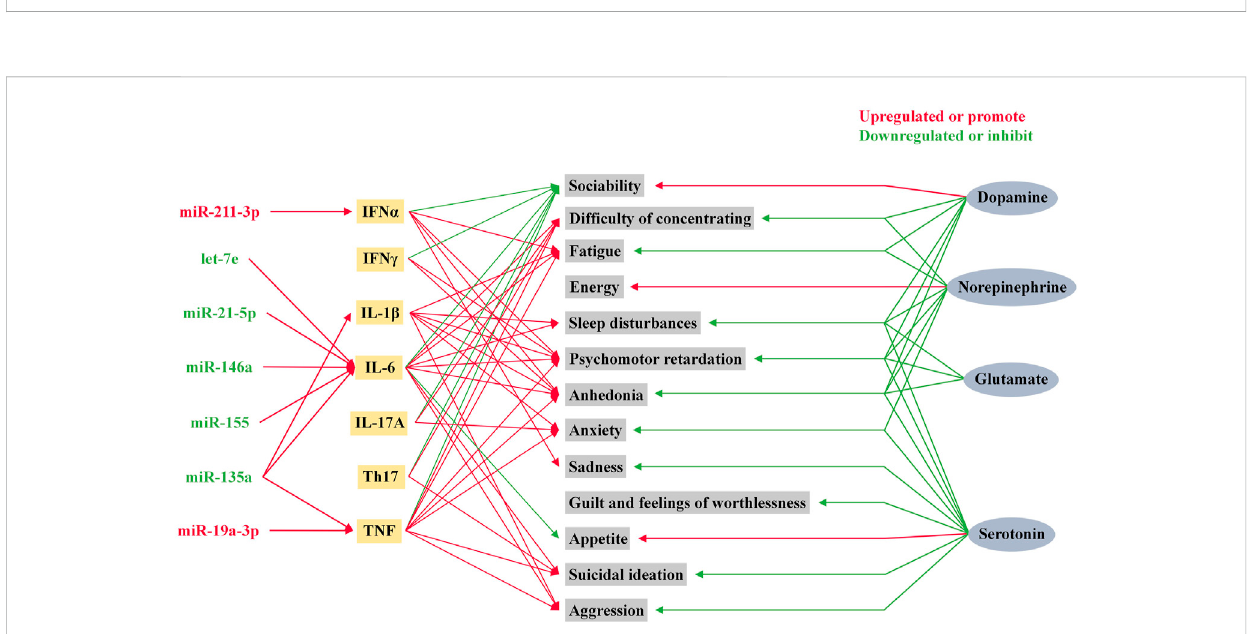
Role of microRNAs in in fl ammatory factors and neurotransmitters in depression. Psychiatric symptoms in humans are in fl uenced by a variety of neurotransmitters and in fl ammatory factors. Among these in fl ammatory factors, IL-1 β , IL-6, TNF, and IFN α are in fl uenced by microRNA